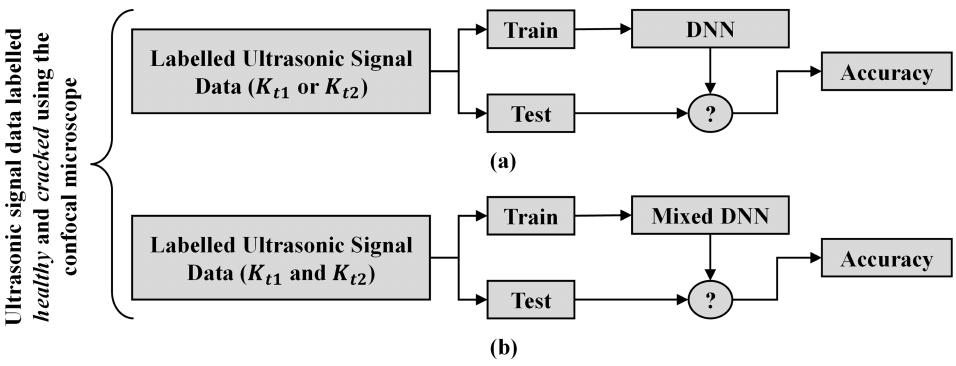
Figure 9. ( a ) Using the healthy and cracked labels from the confocal microscope, an individual DNN can be trained and tested for either K t 1 or K t 2 using the respective dataset. ( b ) A single mixed DNN can be trained and tested from both K t 1 and K t 2